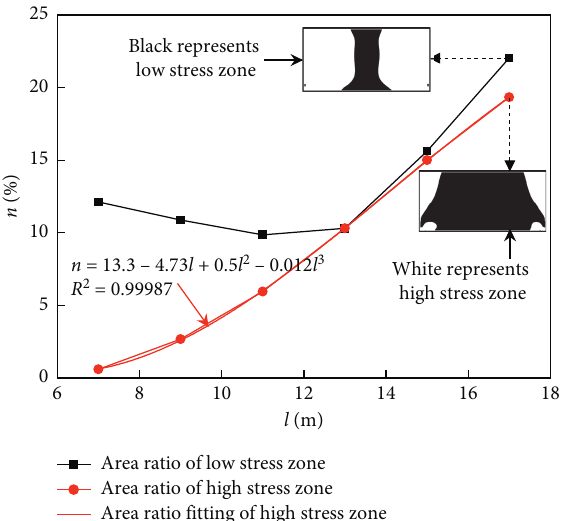
Figure 13: Area ratio distributions of low and high stress zones in ARBBS with different spans.